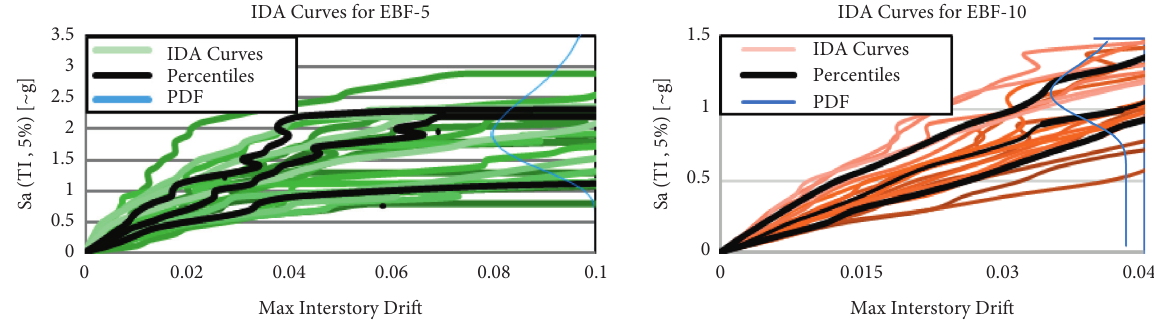
Figure 22: IDA curves obtained from right to left for EBF-5 and EBF-10.